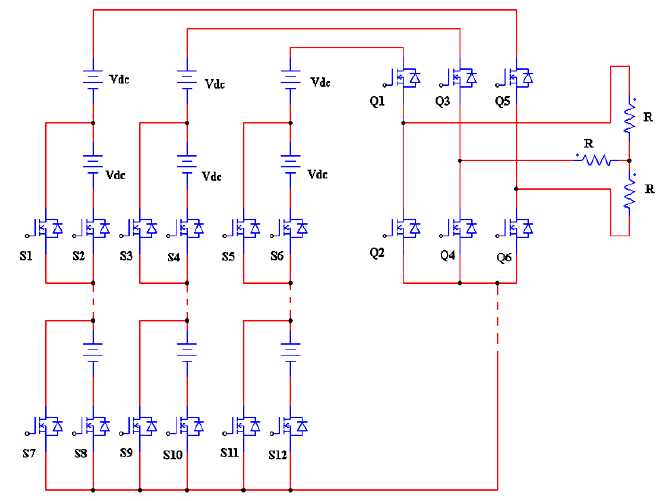
Figure 28. MLI circuit (asymmetric mode).